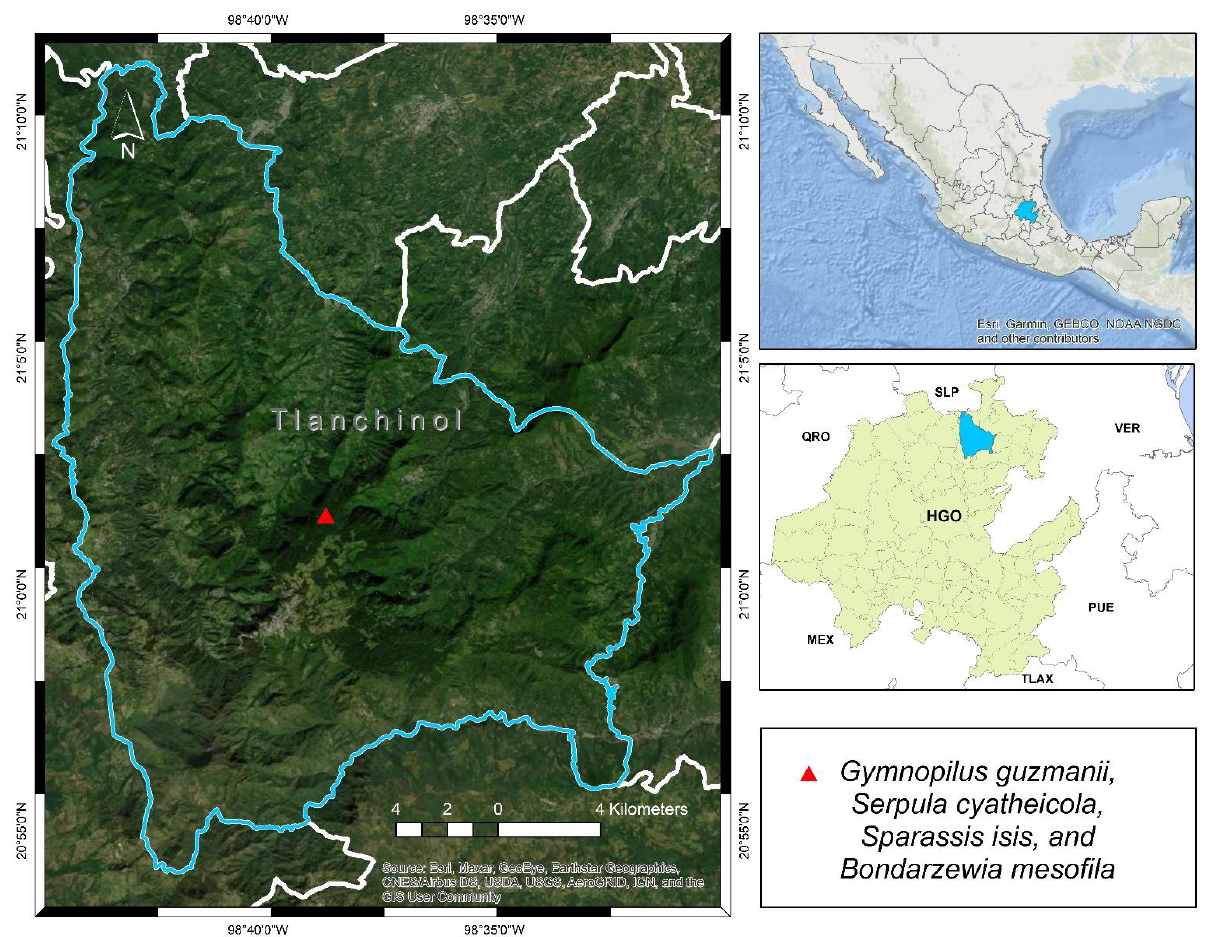
Figure 4. Distributional map of the species. Mexican states abbreviations are as follows: HGO,